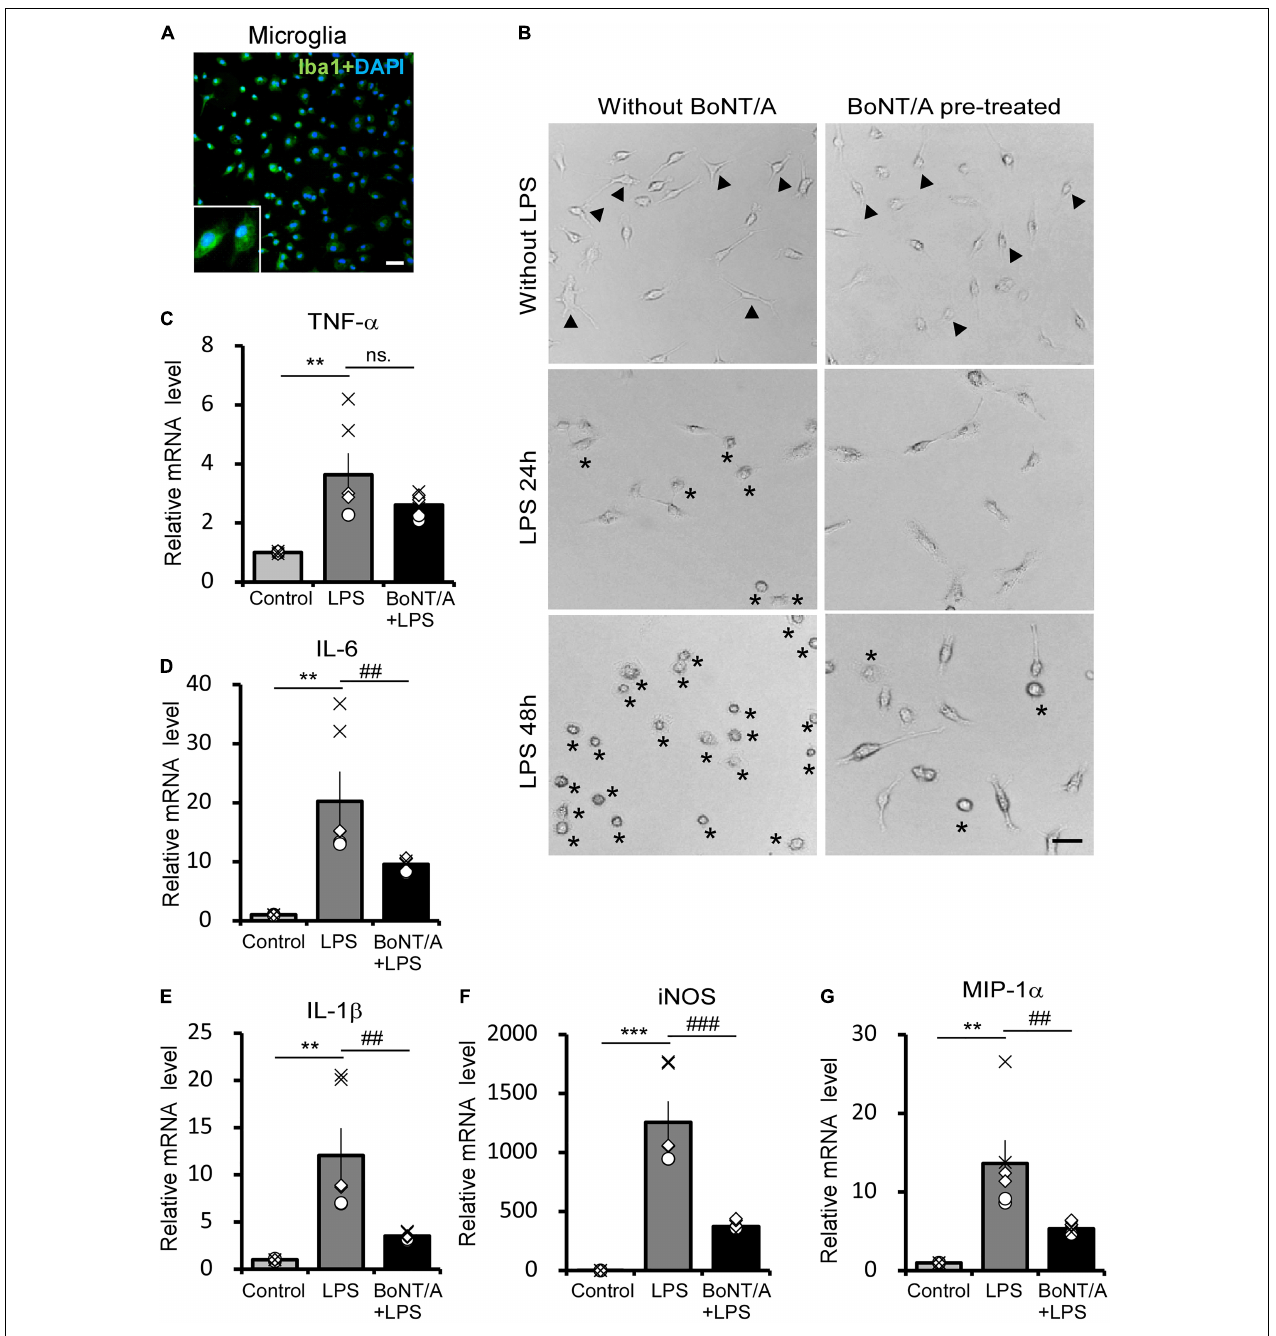
FIGURE 1 | Botulinum neurotoxin A (BoNT/A) pretreatment inhibits lipopolysaccharide (LPS)-activated morphological changes and inflammatory cytokine release in primary microglia. (A) Image showing double-staining with Iba1 (a specific marker of microglia, green) and 4 (cid:48) ,6-diamidino-2-phenylindole (DAPI, blue) in purified microglia from the cerebral cortices of newborn Sprague-Dawley (SD) rats. Scale bar: 100 µ m. (B) Representative morphologies of cultured microglia visualized with a phase contrast microscope. Cells were pretreated with or without BoNT/A (1 U/mL) for 48 h prior to incubation with LPS (10 ng/mL) for 24 or 48 h. Arrowheads indicate the representative resting microglia, showing either a typical elongated, bipolar, or unipolar shape. Asterisks indicate the representative activated microglia which exhibit a typically ameboid morphology. Scale bar: 50 µ m. (C–G) mRNA expression of tumor necrosis factor alpha (TNF- α , C ), interleukin-6 (IL-6, D ), interleukin-1 β (IL-1 β , E ), inducible nitric oxide synthase (iNOS, F ), and macrophage inflammatory protein (MIP)-1 α (G) relative to β -actin. Data are presented as the fold change compared to control group (without any treatment). BoNT/A pretreatment significantly reduced the LPS-induced upregulation of the mRNA levels of TNF- α , IL-6, IL-1 β , iNOS, and MIP-1 α . Three independent experiments were performed with 2 replicates for each experiment. Data are represented as the mean ± SEM. A non-parametric two-tailed t -test was used for comparison. *** p < 0.001, ** p < 0.01 compared to control group; ### p < 0.001, ## p < 0.01, and ns. denotes no significance compared to the LPS-treated